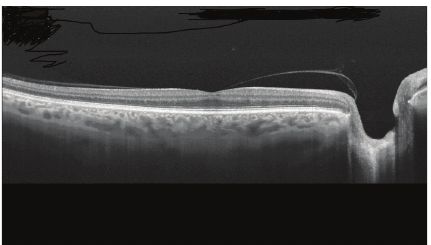
Figure 1: Horizontal image with swept-source OCT at the foveal level showing posterior vitreous detachment, which remains adhered to the fovea and the papillary